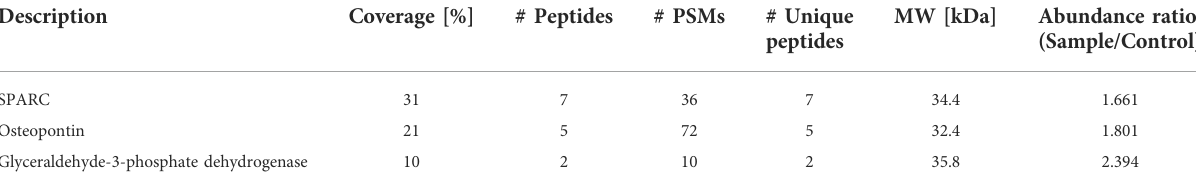
TABLE 1 Protein candidates fi ltered from semi-quantitative comparison of proteins abundant in MOE PTEN shRNA when compared with MOE SCR shRNA . Protein IDs were fi ltered with the following parameters: abundance ratio (MOE PTEN shRNA /MOE SCR shRNA ) > 1.0, molecular weight (MW) 25 – 40 kDa, Species: Mus musculus , and sequence coverage > 8%. PSMs is peptide spectrum